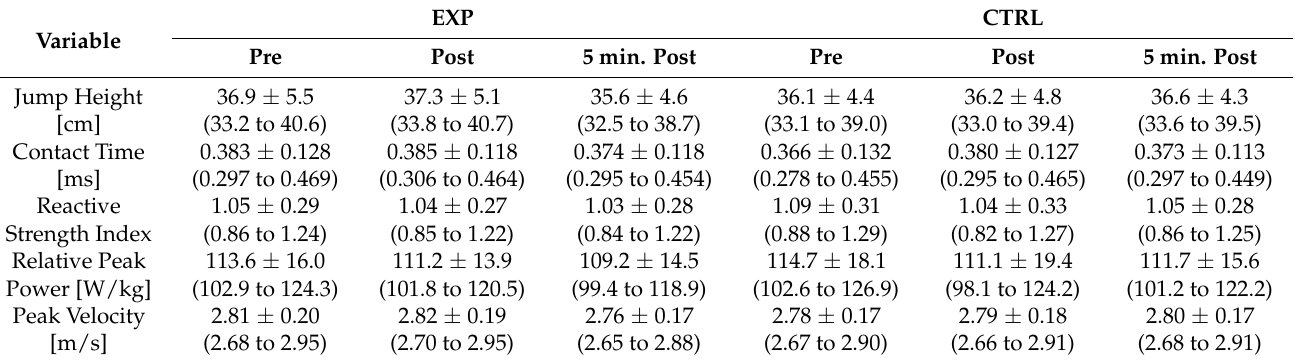
Table 2. Comparisons of pre- and post-PM drop jump and Achilles tendon